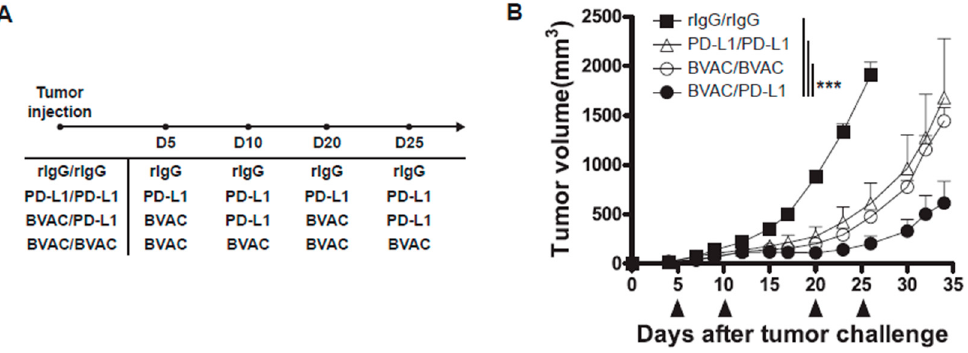
Figure 6. The e ff ect of the combination of BVAC-K1117 with anti-PD-L1 antibody therapy on CT26 / HER2 tumor-bearing mice. We inoculated 5 × 10 5 CT26 / HER2 cells into naïve BALB / c mice, and vaccinated the mice with the indicated therapy on days 5 and 10 for the first cycle and on days 20 and 25 for the second cycle ( A , B ). The dose per treatment of BVAC was 2 × 10 6 cells per mouse and anti-PD-L1 antibody (MIH5) was 300 µ g per mouse. All data are representative of two independent experiments (*** p < 0.001).